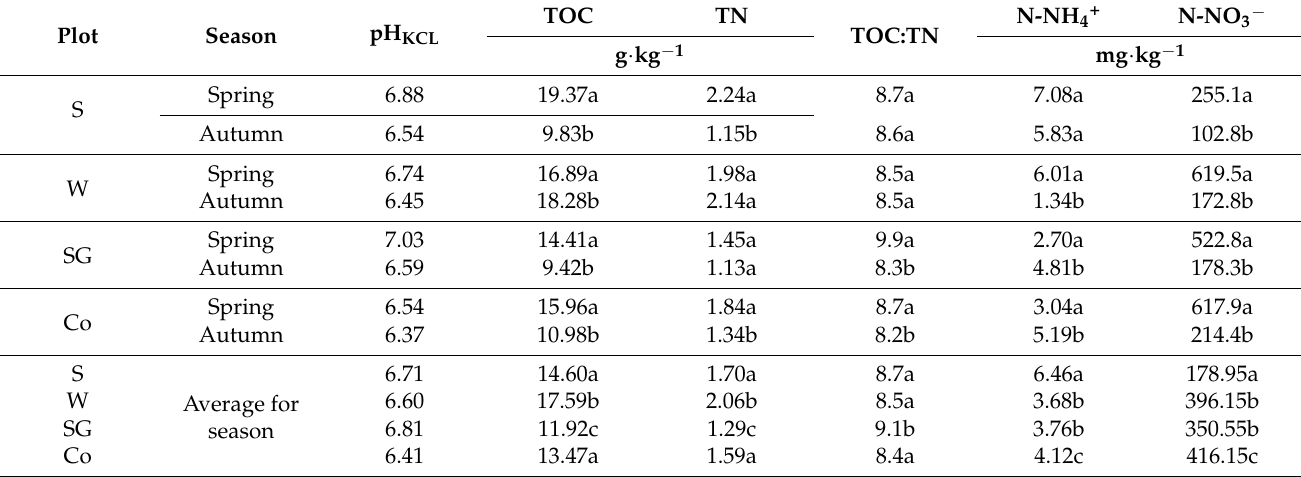
pen W (Table 3). The values of the TOC:NT ratio in the analyzed soils ranged from 8.2 to 9.9 (Table 3). The values of the TOC:NT ratio in the soil from pen SG were significantly higher than in the soils from the other experimental pens. Table 3. Physicochemical properties of the soils